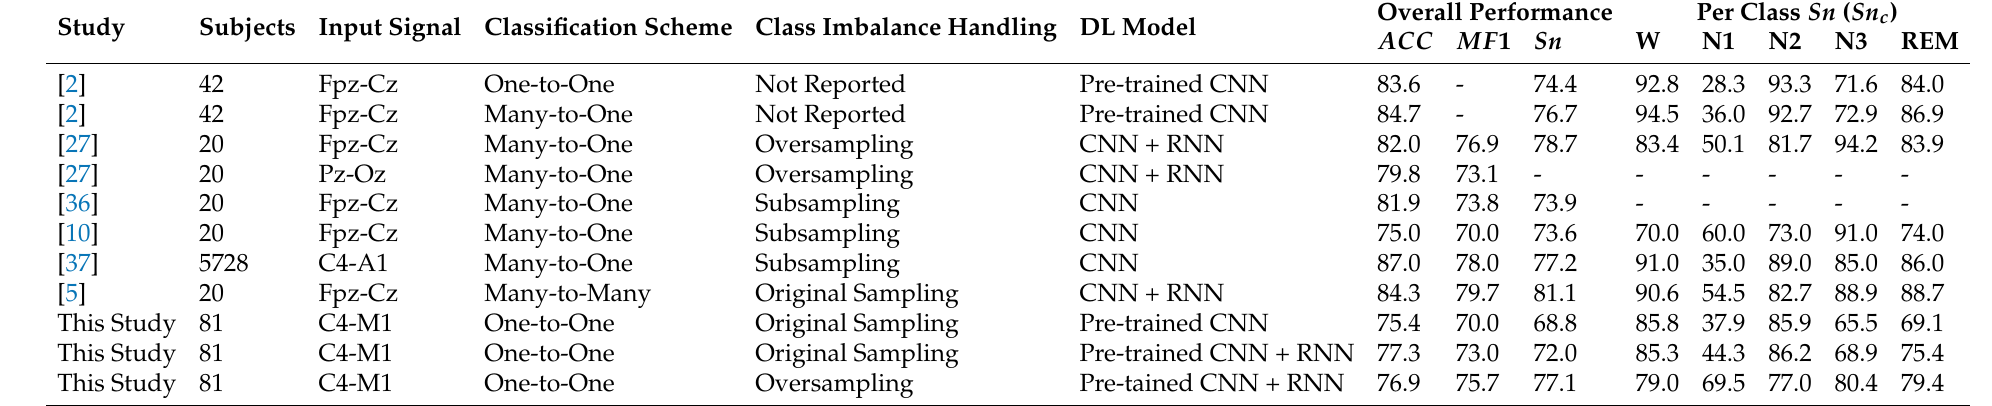
Table 8. Comparison between the proposed method and other end-to-end deep learning methods for automatic detection of sleep stages using a single EEG